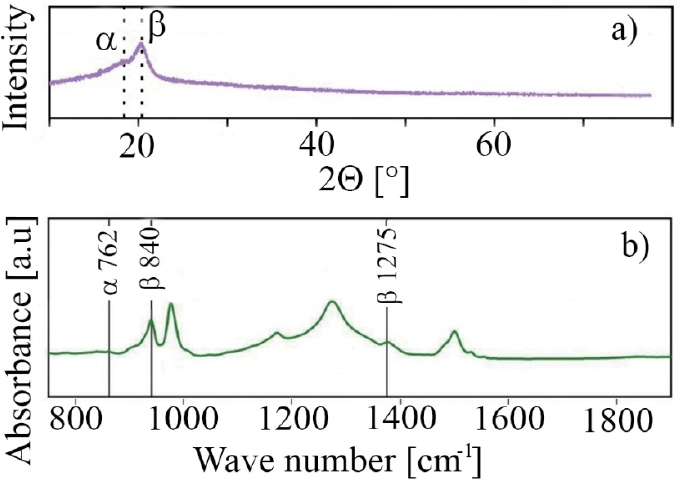
Figure 2. Part ( a ) represents XRD analysis and part ( b ) FT-IR analysis, both for electrospun PVDF fibre network.